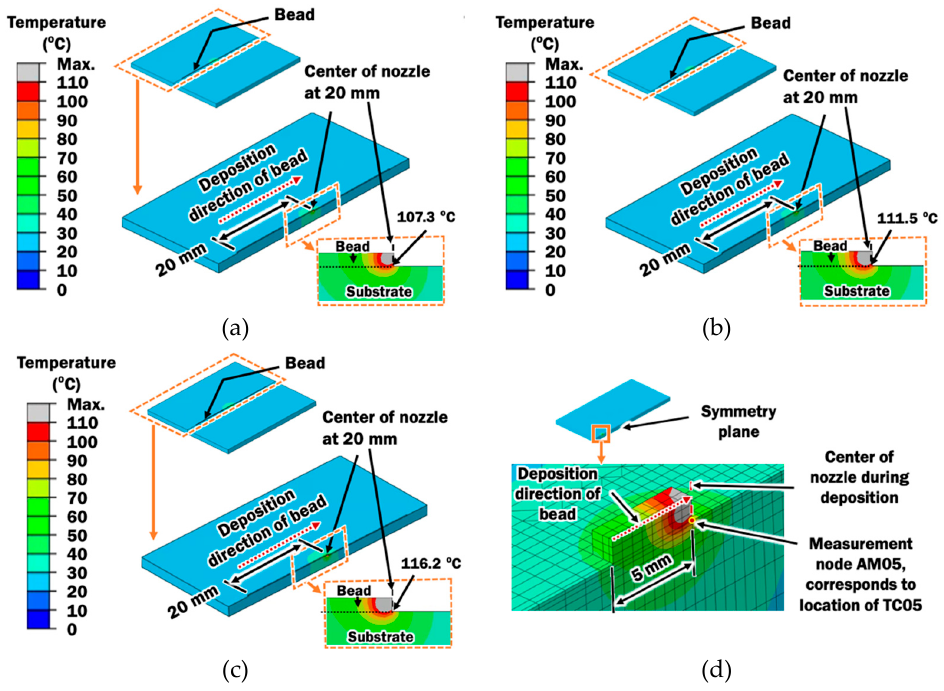
Figure 12. Estimated temperature distributions during the deposition of a bead with nozzle’s loca- tion at 20 mm from the start point for different printing temperatures: ( a ) T p = 230 °C; ( b ) T p = 240 °C; ( c ) T p = 250 °C; ( d ) location of measurement node AM05 on the ABS substrate corresponding to locations of thermocouples TC05.